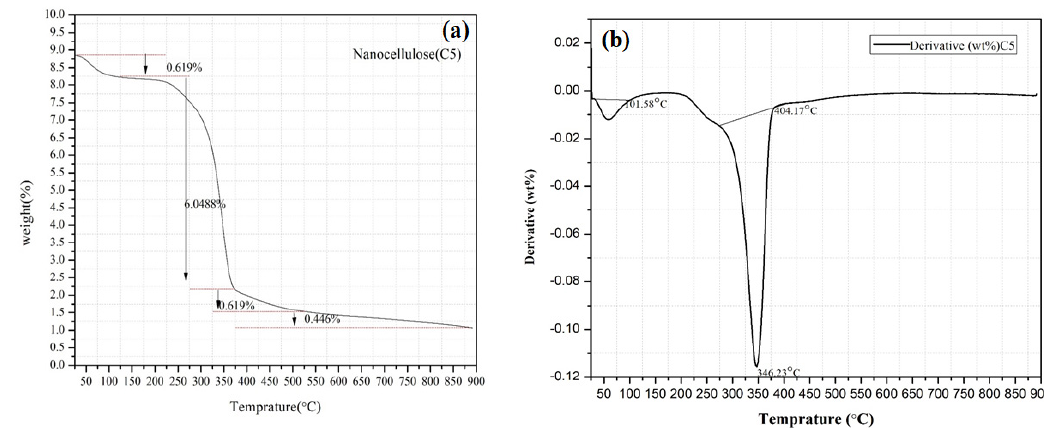
Fig.9. (a) Thermogravimetric analysis (b) Differential Thermogravimetric